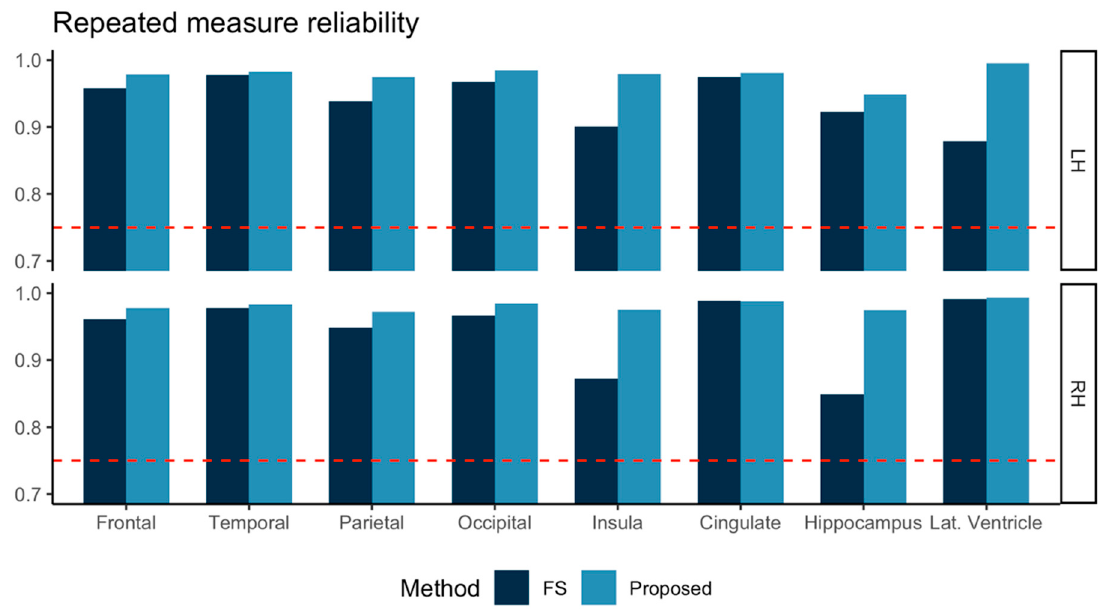
Figure 3. Repeated measure reliabilities for the volumes in eight sub-regions in left and right hemispheres (LH, RH) were evaluated using intraclass correlation (two-way, consistency) for three subjects scanned at 12 different sites. FreeSurfer (FS, dark blue) and the proposed method (light blue) are marked together for comparison. Other than the lateral ventricle (Lat. Ventricle) area, all the volumes were measured for gray matter tissue.